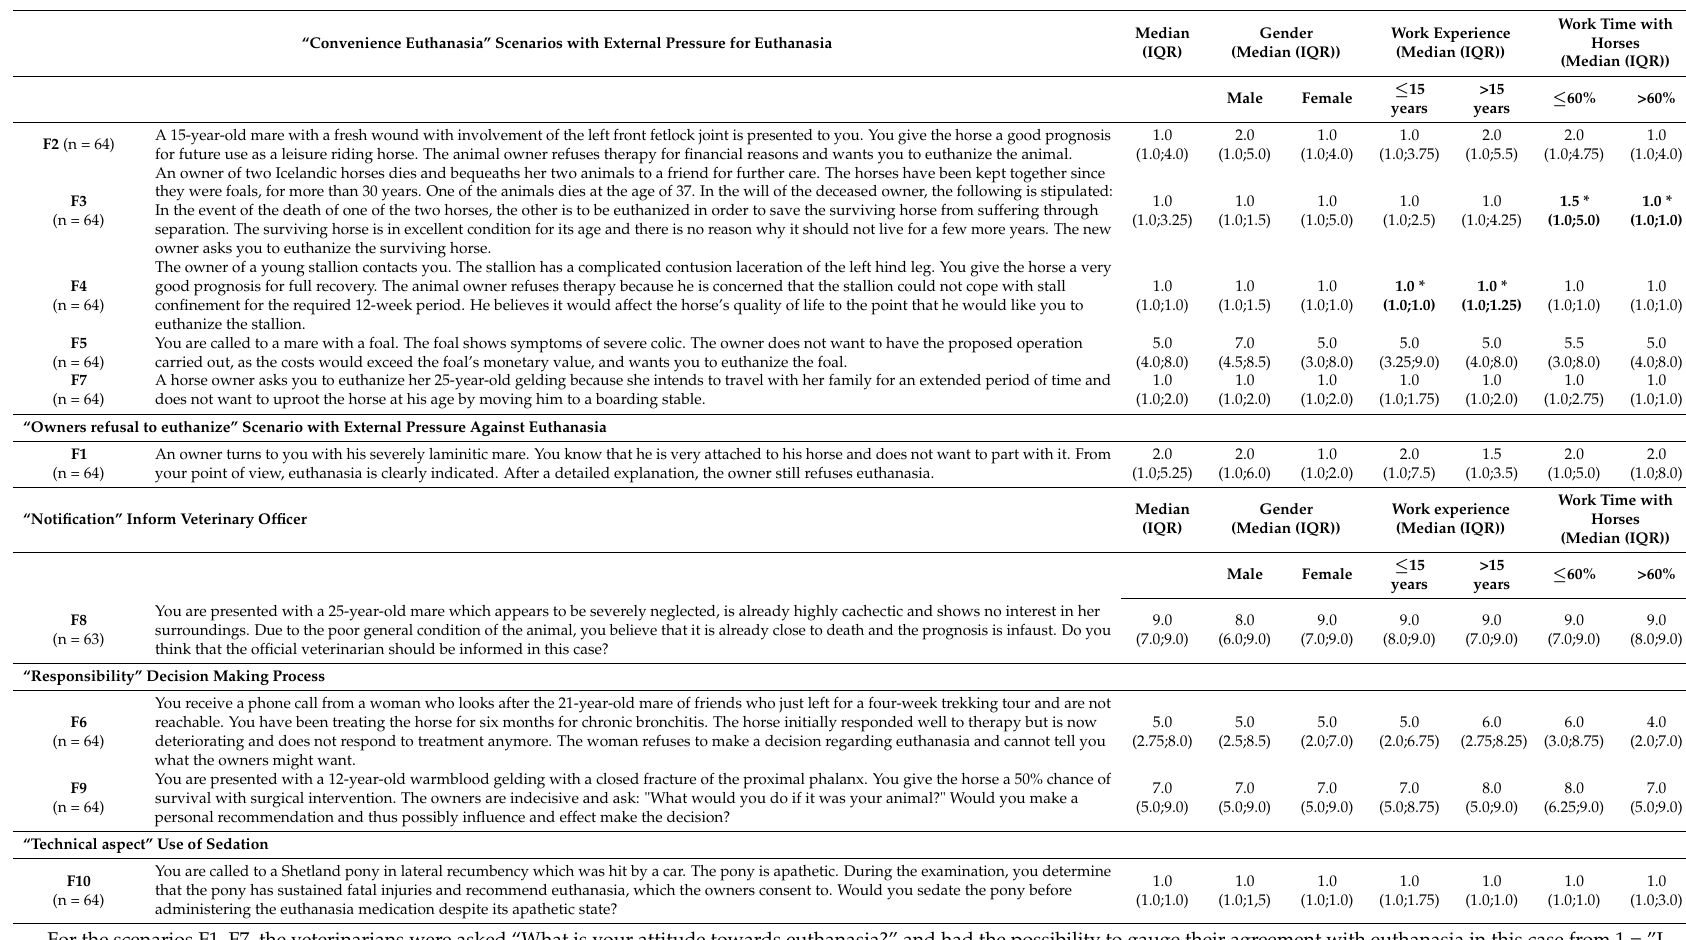
Table 3. Veterinarians’ level of agreement with the endorsement of euthanasia in ten scenarios in equine practice. “Convenience Euthanasia” Scenarios with External Pressure for